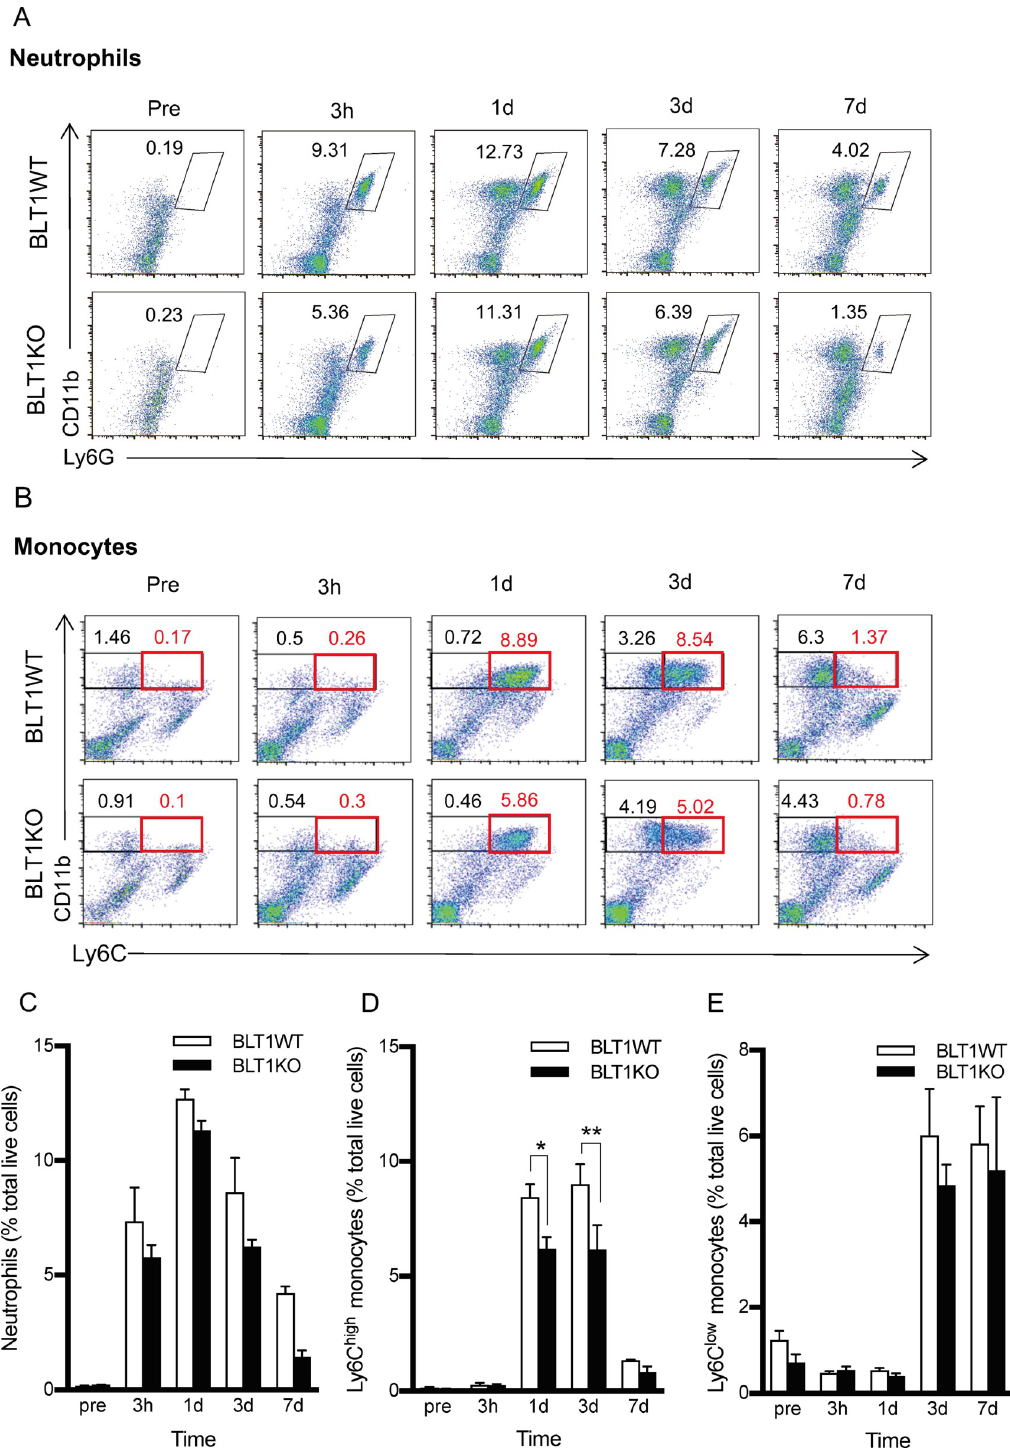
Fig 3. Leukocyte infiltration in the plantar tissue after the paw incision. The percentage of neutrophils (CD11b + Ly6G + ) and Ly6C high and Ly6C low monocytes were measured in the plantar tissue collected from BLT1KO and BLT1WT mice at different time points after the incision. A, Representative forward/scatter dot plots showing the percentage of neutrophils. B, Representative forward/scatter dot plots showing percentages of Ly6C high (red square gate) and Ly6C low monocyte populations (black square gate). C, The percentage of neutrophils increased and peaked on day 1 in both groups, but there was no significant